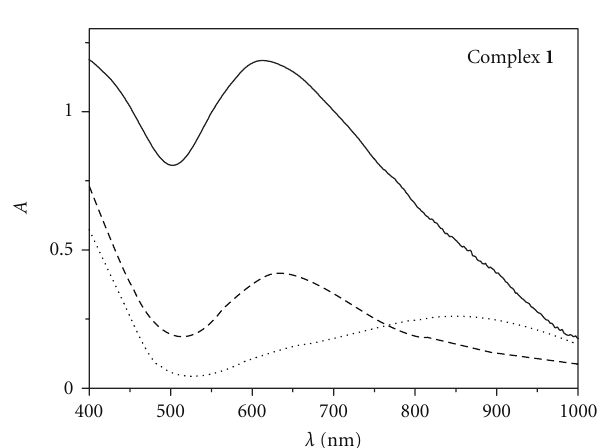
Figure 3: Di ff use-reflectance (solid line) and electronic (10 − 3 DMF solution) spectra of complex 1 ; dashed line: freshly made solution, dotted line: after 24